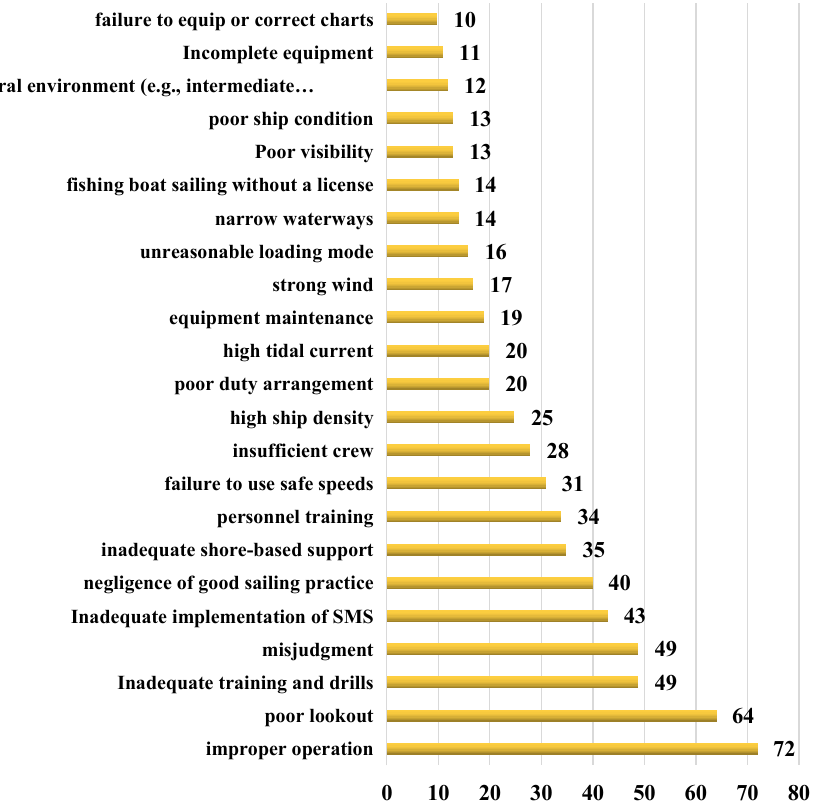
Figure 4. Frequency of the features of marine accidents.